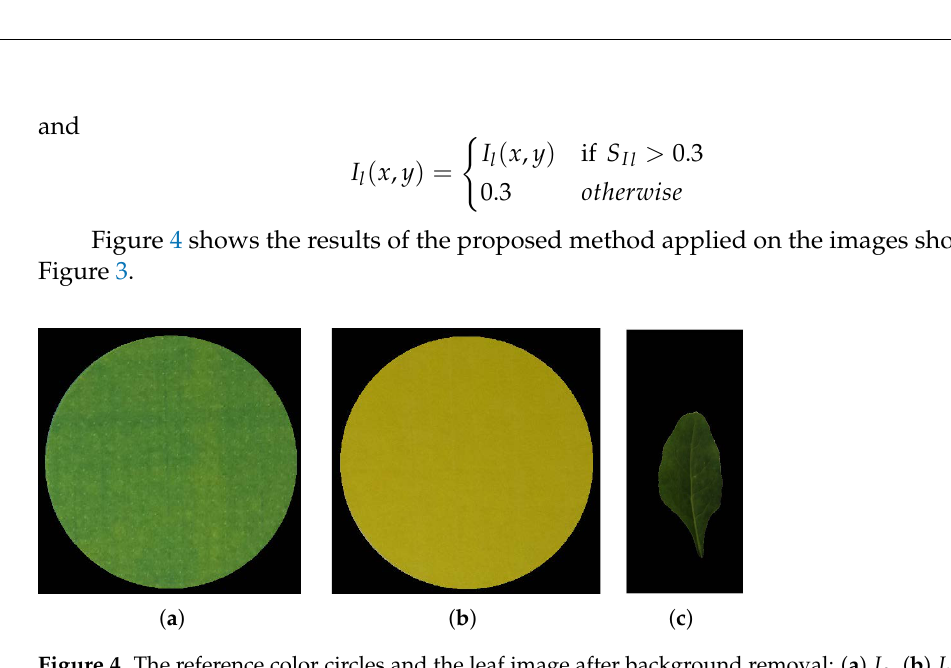
Figure 4. The reference color circles and the leaf image after background removal: ( a ) I g , ( b ) I y , ( c ) I l